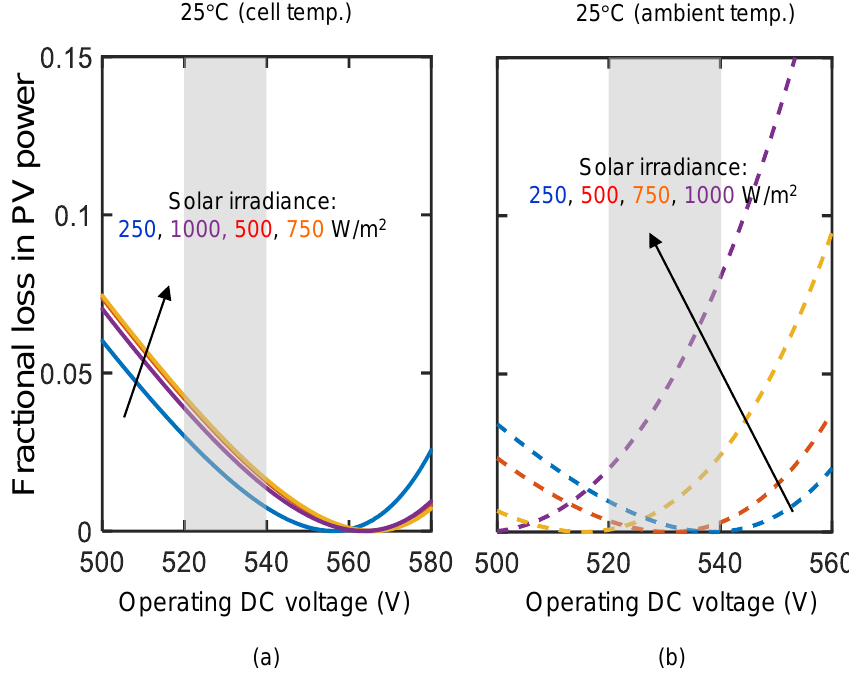
Figure 4. Loss of solar PV power due to deviation in the MPP voltage under varying sunshine conditions for different operating DC voltage are shown assuming ( a ) STC conditions, i.e., cell temperature at 25 ◦ C, and ( b ) practical conditions, i.e., ambient temperature of 25 ◦ C. Load power is greater than 5